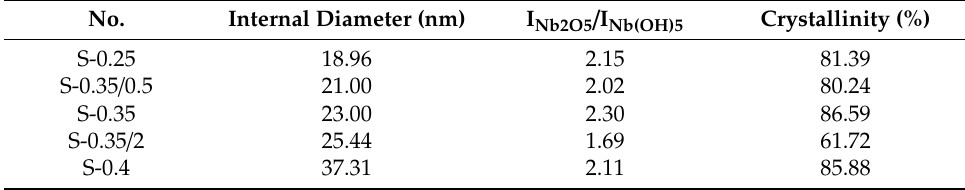
Table 2. Characteristic parameters of as-prepared samples after 2 h of electrooxidation at 20 V.